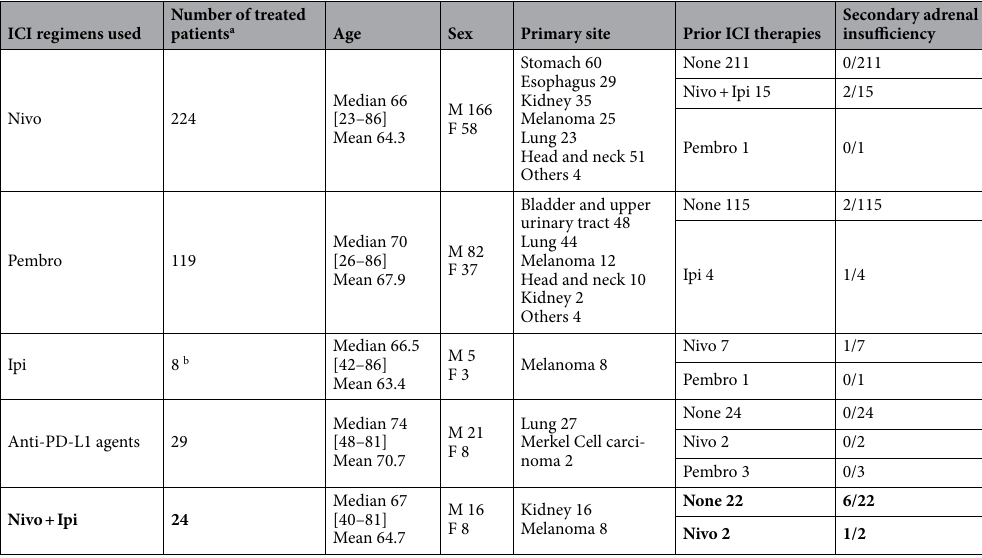
Table 1. Number of treated patients and ICI regimens used. ICI, immune checkpoint inhibitor; nivo, nivolumab; pembro, pembrolizumab; ipi, ipilimumab, M, male; F, female. (a) Some patients were treated with multiple regimens and the “Number of treated patients” is therefore greater than the actual number of patients (n = 373). (b) All 8 cases treated with ipilimumab alone had undergone a first-line therapy with anti-PD-1 antibodies (nivolumab or pembrolizumab).